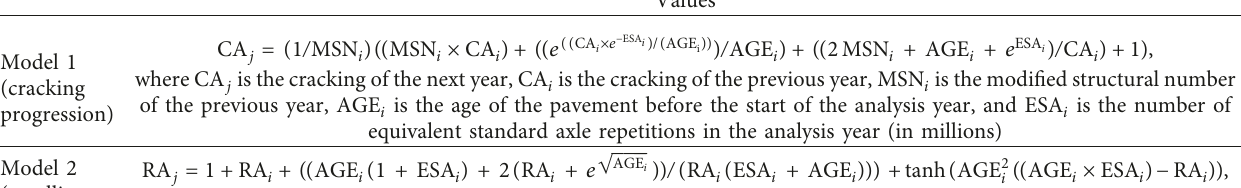
Table 5: GP models for progression of cracking, potholes, ravelling, rutting, and roughness for urban roads.